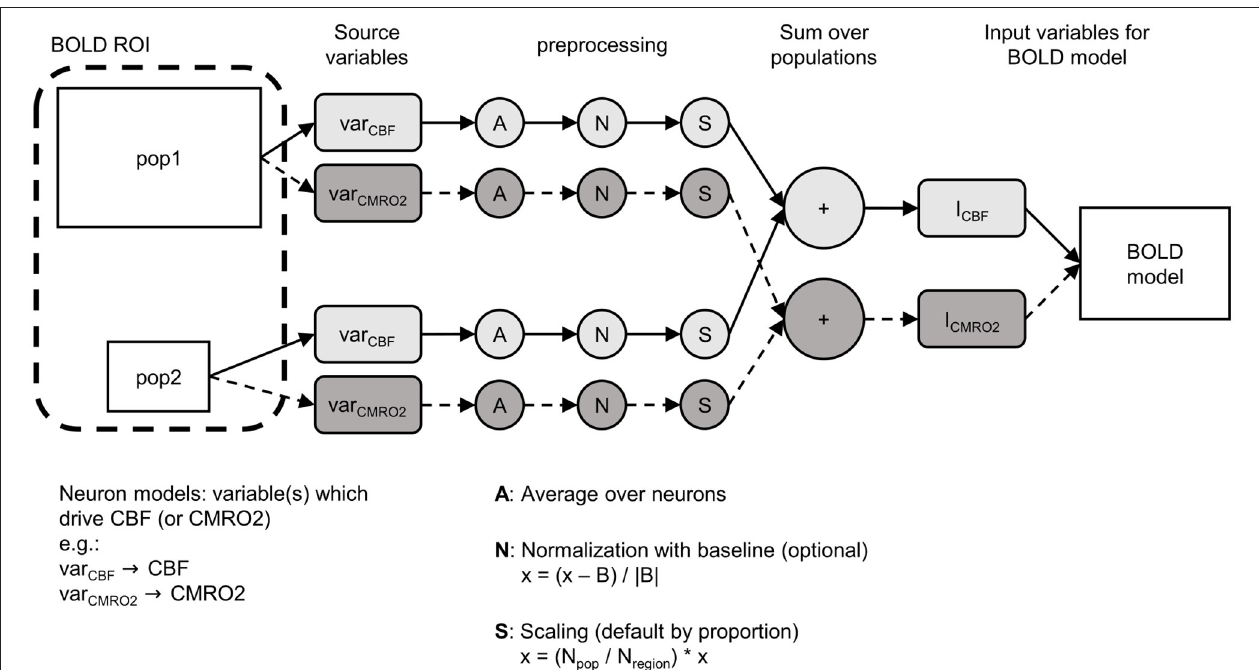
FIGURE 2 | Schematic overview of how the BOLD monitor calculates the input signals (here I CBF , I CMRO2 ) for a BOLD model (e.g., Balloon model). The ROI from which the BOLD signal should be calculated can consist of multiple populations (here pop1, pop2). In the neuron models of each population, the variables (var CBF , var CMRO2 ) have to be defined, which are used to calculate the input signals (referred to as source variables). Three preprocessing steps are applied to the source variables per population: (1) averaging over all neurons of the population, (2) optional normalization, (3) scaling by proportion of the population in the ROI. Finally, the signals resulting from the preprocessed source variables are summed across all populations and fed into the BOLD model as input signals. x, the averaged signal; B, baseline; N pop , size of the population; N region , total number of neurons in the